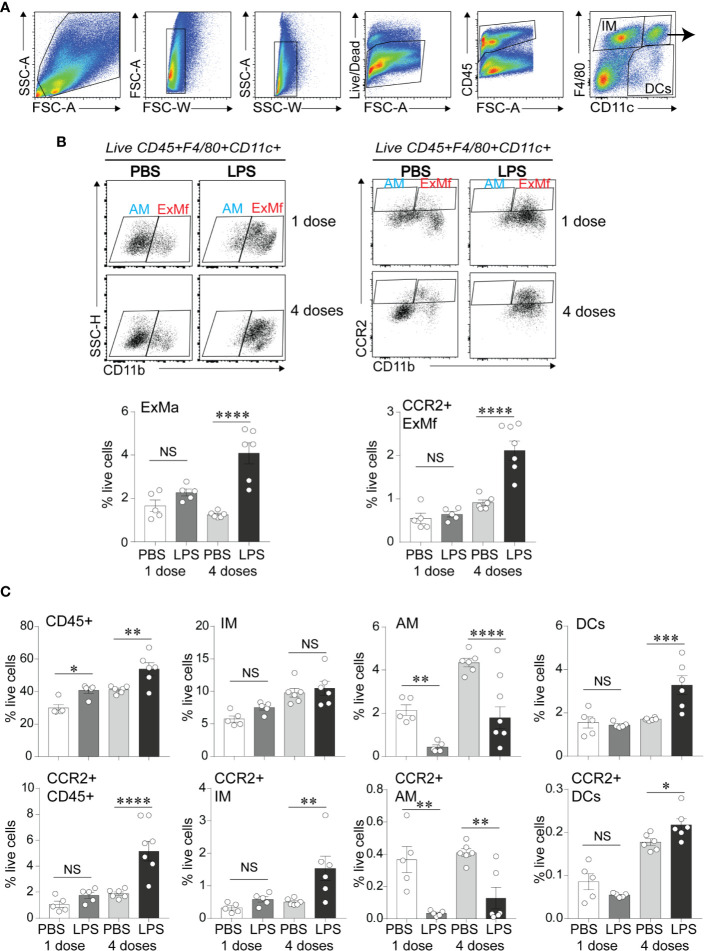
CCR2+ exudative macrophages are recruited to neonatal lungs after repetitive airway LPS exposure. Immature mice were inoculated with LPS or PBS intranasally on days of life 3, 5, 7, and 10. Lung digests obtained after the first and after the last (fourth) LPS inocculation were subjected to flow cytometry. (A) Flow gating strategy used to identify viable, CD45+ cell populations of lung macrophages (F4/80+CD11c+), dendritic cells (DCs; F4/80− CD11c+) and interstitial macrophages/monocytes (IMs; F4/80+CD11c−). (B) Lung F4/80+CD11c+ cells were analyzed for expression of CD11b to distinguish alveolar macrophages (AMs; F4/80+CD11c+CD11b−) from exudative macrophages (ExMf; F4/80+CD11c+CD11b+), and for expression of CCR2 to determine the CCR2-expressing AMs and ExMf, defined by the gates based on FMO control. The populations of ExMf and CCR2+ ExMf were significantly increased after repetitive LPS exposure. (C) Comparison of total live, CD45+ cells, IMs, AMs, DCs, as well as CCR2+CD45+, CCR2+IMs, CCR2+ AMs, CCR2+DCs in PBS- and LPS-exposed lungs. N = 3–6 mice per group. NS is non-significant difference, *P < 0.05, **P < 0.01, ***P < 0.001, ****P < 0.0001, one-way ANOVA.